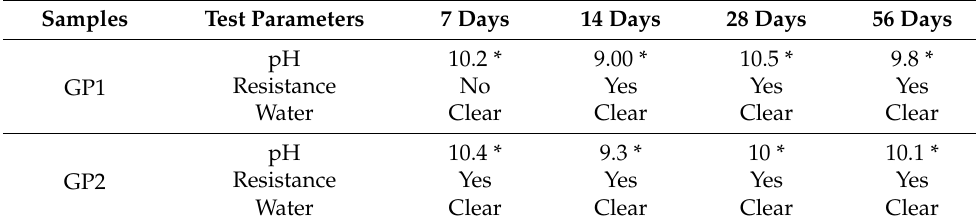
Table 4. Summary of the results of the integrity test vs. ageing time.